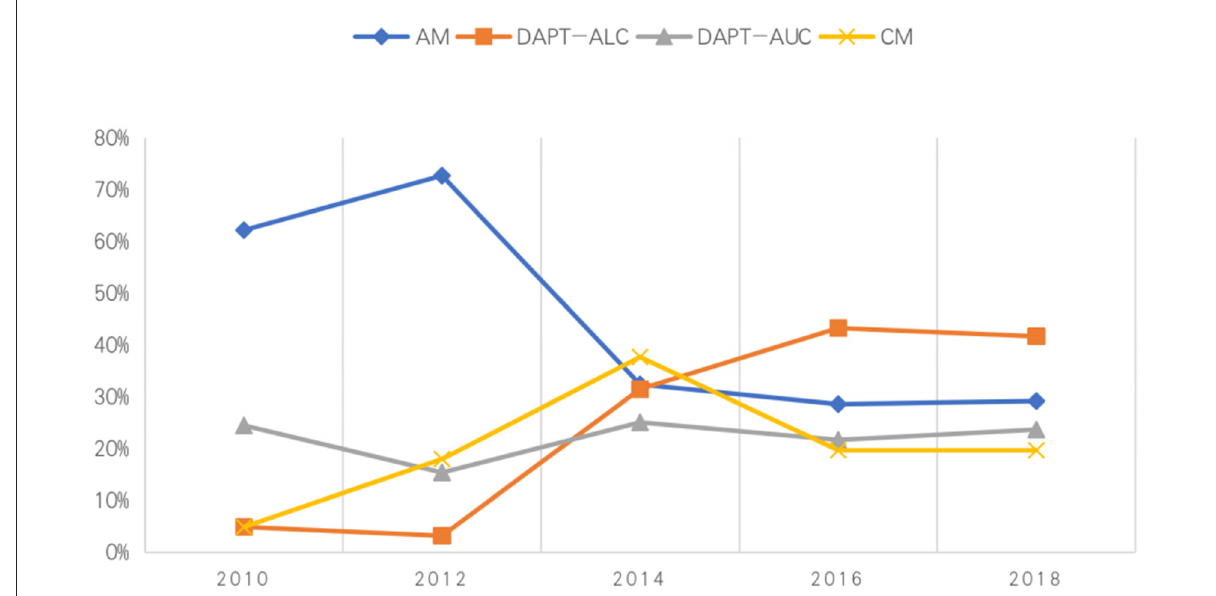
FIGURE3 Percentage of patients admitted to the hospital during 2010–2018 who received different